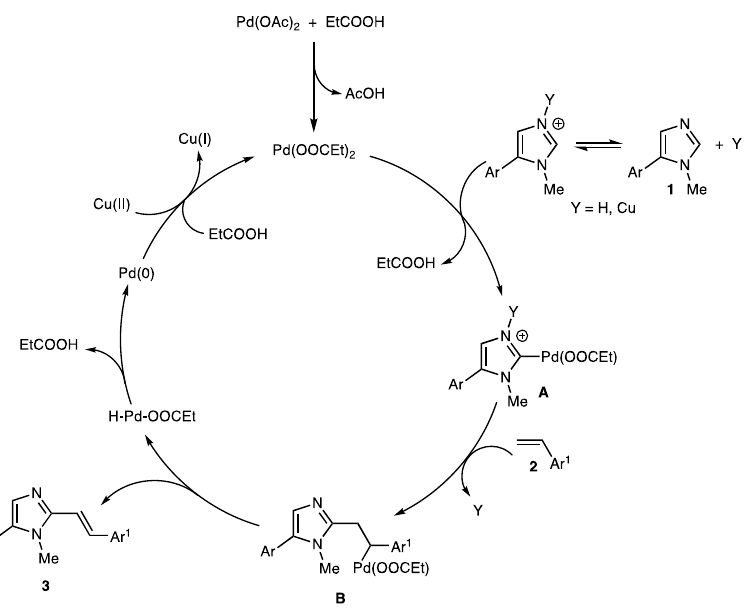
Figure 2. Suggested mechanistic pathway for the Pd/Cu-mediated dehydrogenative alkenylation of